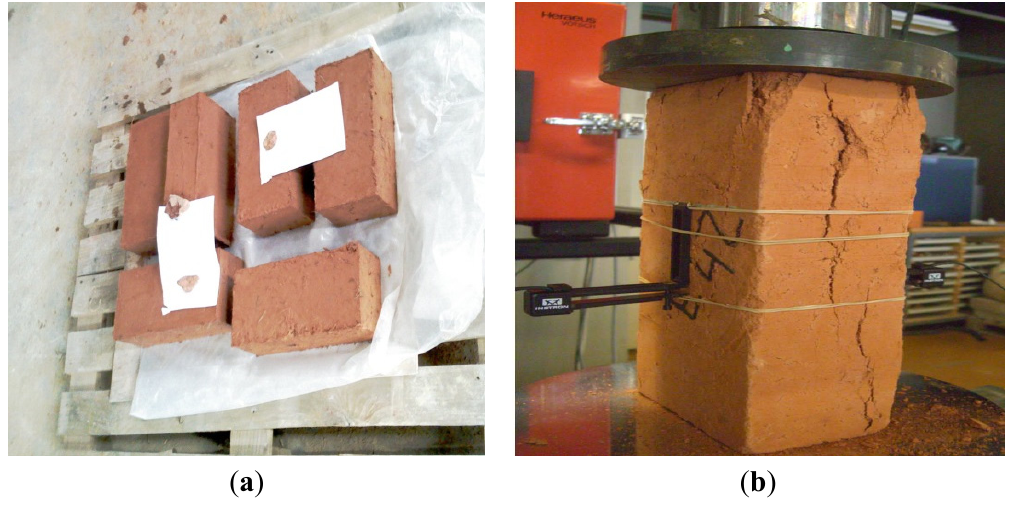
Figure 2. Compression test samples before test ( a ), sample after test with an extensometer in the central part of the sample measuring the strain ( b